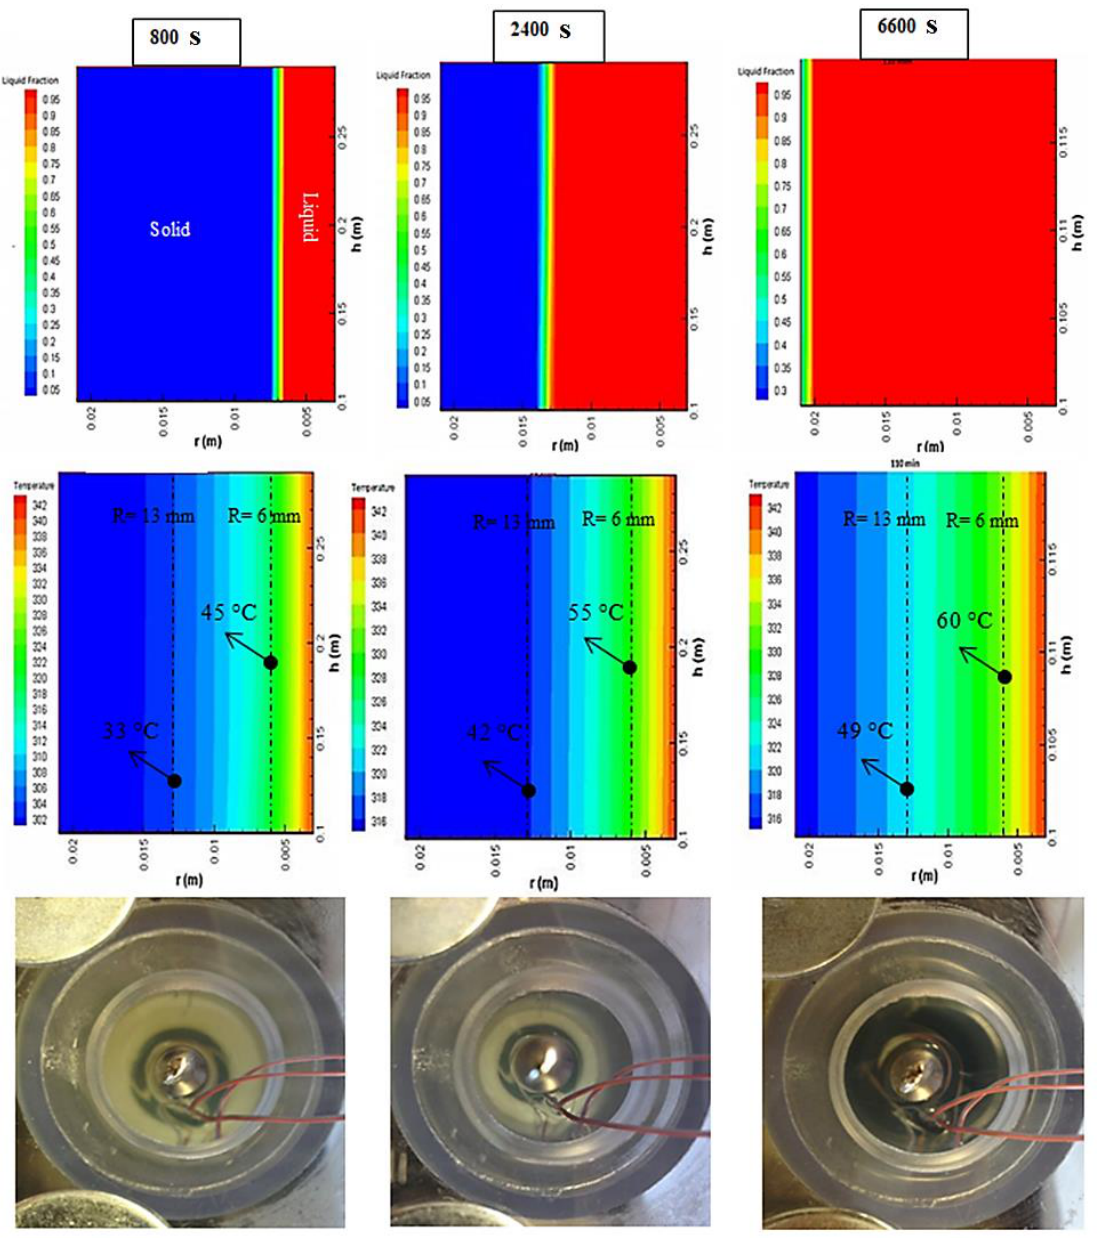
Figure 10. Experimental melting photos ( bottom ), numerical temperature contour ( middle ), and numerical liquid fraction in PCM ( top ) during the charging process (T = 70 °C) .